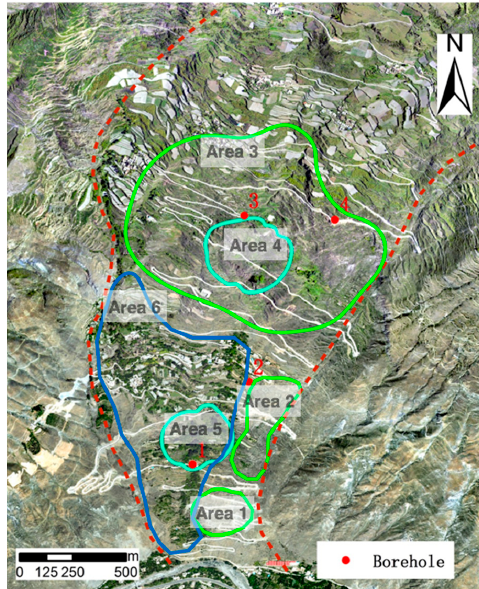
Figure 2. Landslide map with locations of the geotechnical monitoring instrumentation and landslide boundary outlined in red. Red Dots 1–4 indicate the existing boreholes. Areas 1–6 will be introduced in the following sections.